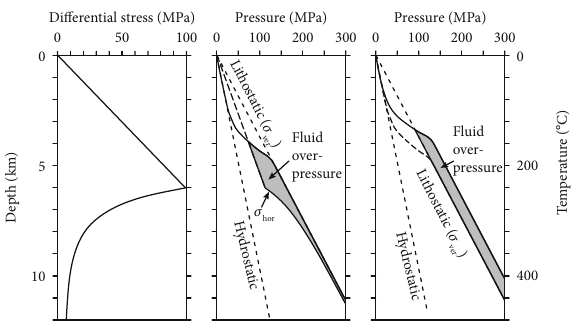
Figure 3: Schematic di ff erential stress and pressure pro fi les. (a) Absolute di ff erential stress to achieve an extension rate that is depth-independent, assuming a maximum di ff erential stress of 100 MPa at a brittle-ductile transition of about 6km. (b) In a crust at rest, the fl uid pressure pro fi le would show a transition from hydrostatic at a shallow depth to lithostatic further down. Grey area shows the fl uid overpressure that results from bringing the crust under extension. (c) Exhumation shifts the fl uid pressure pro fi le upward if fl uid cannot escape from the pores. Grey area shows the resulting fl uid overpressure. Both extension and exhumation may thus result in fl uid pressures that exceed the lithostatic and thereby cause fl uid